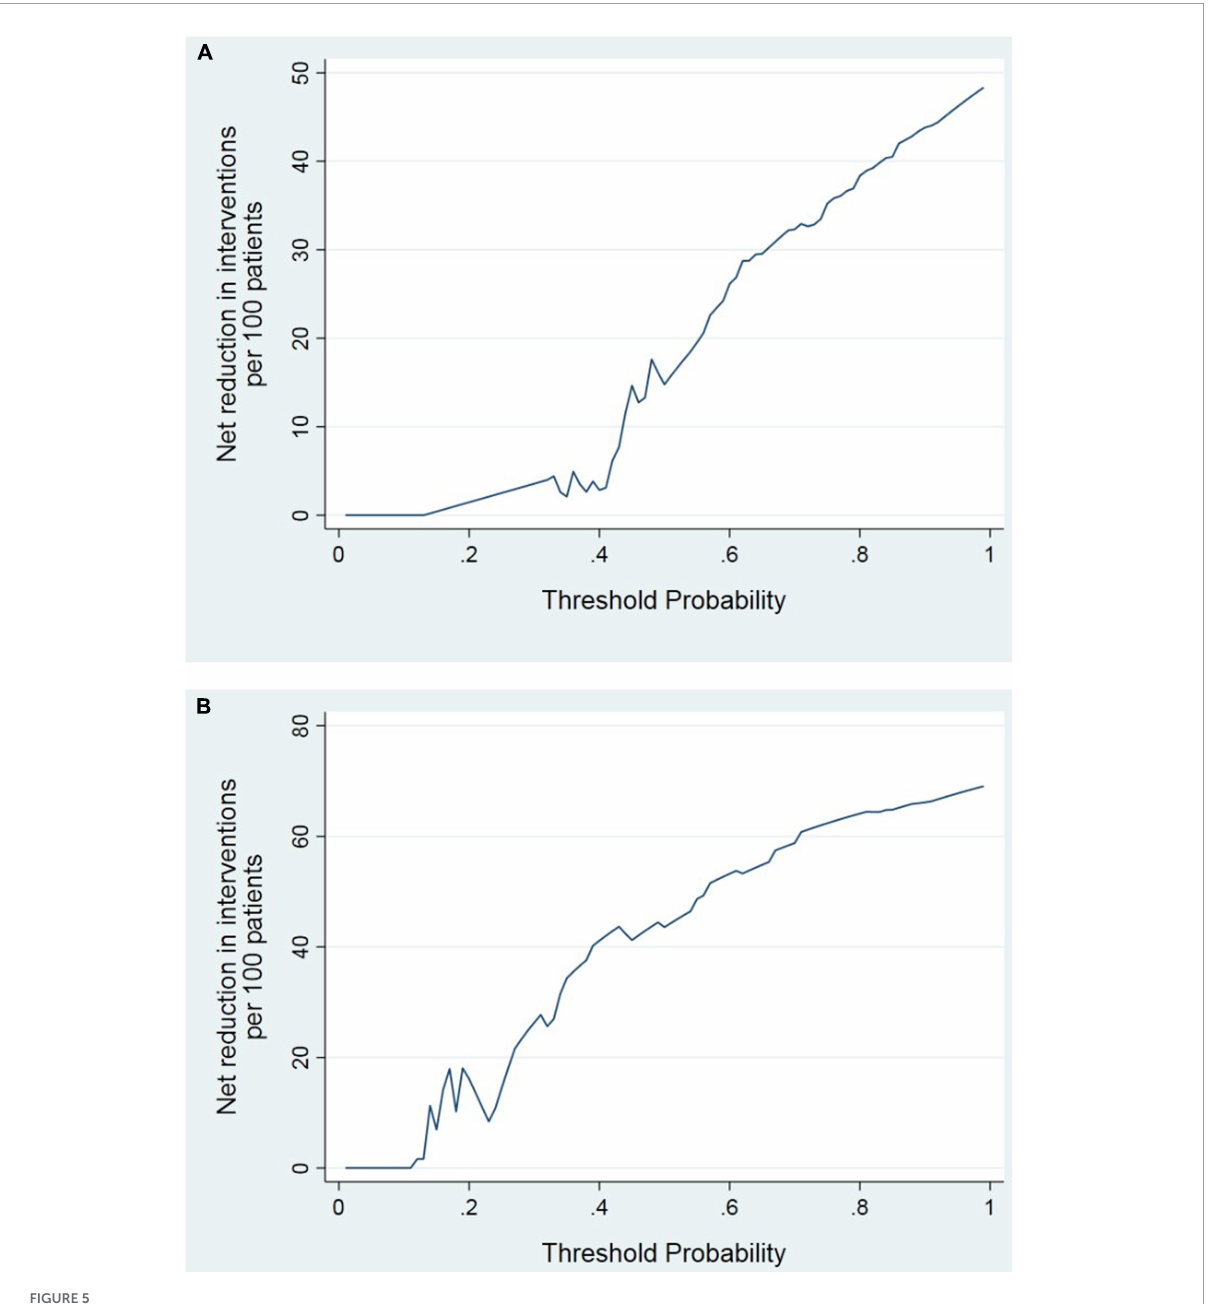
FIGURE5 IAC analysis results. (A) Sepsis vs. non-sepsis; (B) sepsis shock vs. non-sepsis.